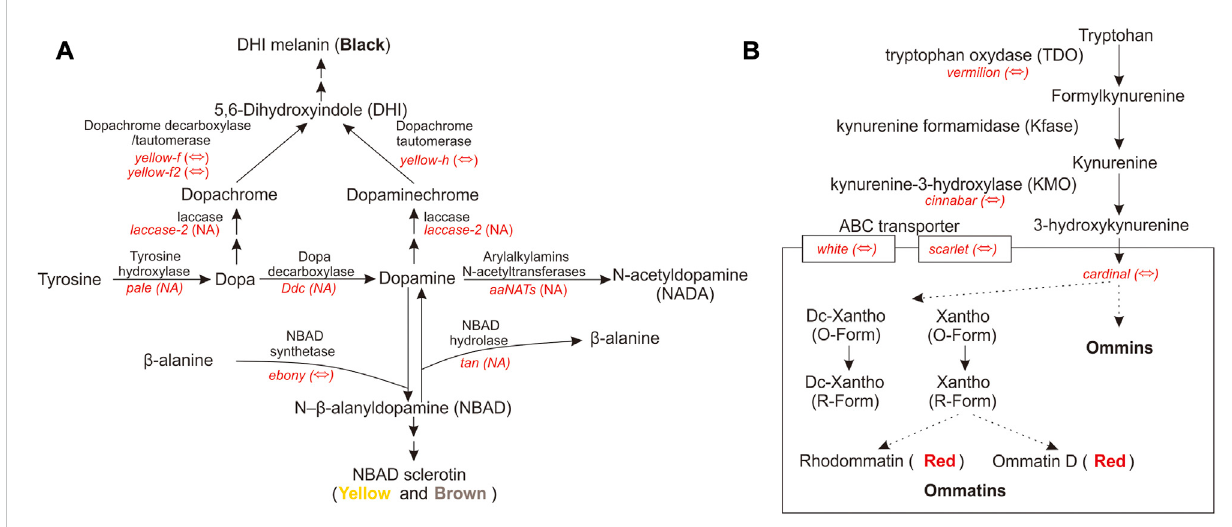
FIGURE 6 Melanin and ommochrome biosynthesis pathways (Sullivan and Sullivan, 1975; O ’ Hare et al., 1984; Searles and Voelker, 1986; ten Have et al., 1995; Yang, 2021; Barek et al., 2022). (A) Key gene products in the melanin biosynthesis pathway. (B) Key gene products in the ommochrome biosynthesis pathway. “ 5 ” indicatesthatthegeneissupportedbyareciprocalBLASThit(RBH)analysis; “ NA ” indicatesthatthegeneiseithernotsupportedbytheRBH analysis or not part of the D. melanogaster AmiGO pigment gene